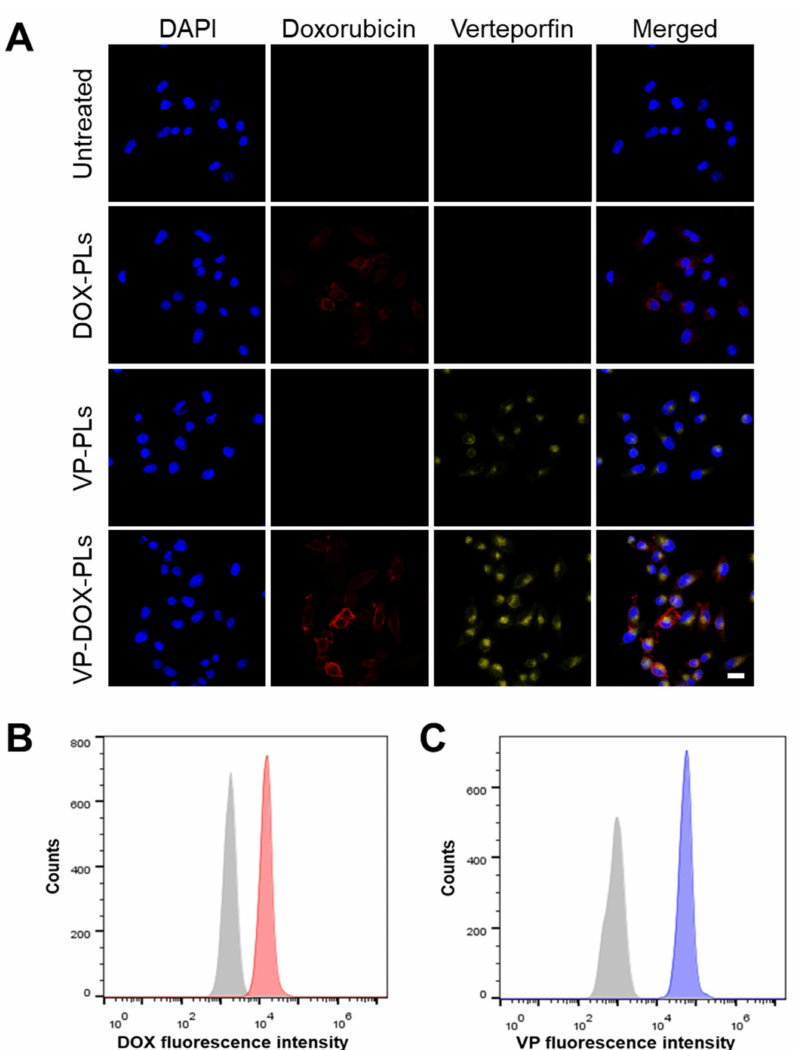
Figure 3. Intracellular uptake of VP-DOX-PLs. Untreated group refers to the negative control. ( A ) Confocal images of intracellular uptake of VP-DOX-PLs. Blue, red, and yellow fluorescence represent the nucleus of the cell, doxorubicin and verteporfin, respectively. Scale bar indicates 20 µ m. Flow cytometry results of VP-DOX-PLs showing the fluorescence intensity of ( B ) doxorubicin (Grey represents negative control and red represents VP-DOX-PLs group) and ( C ) verteporfin (Grey represents negative control and blue represents VP-DOX-PLs